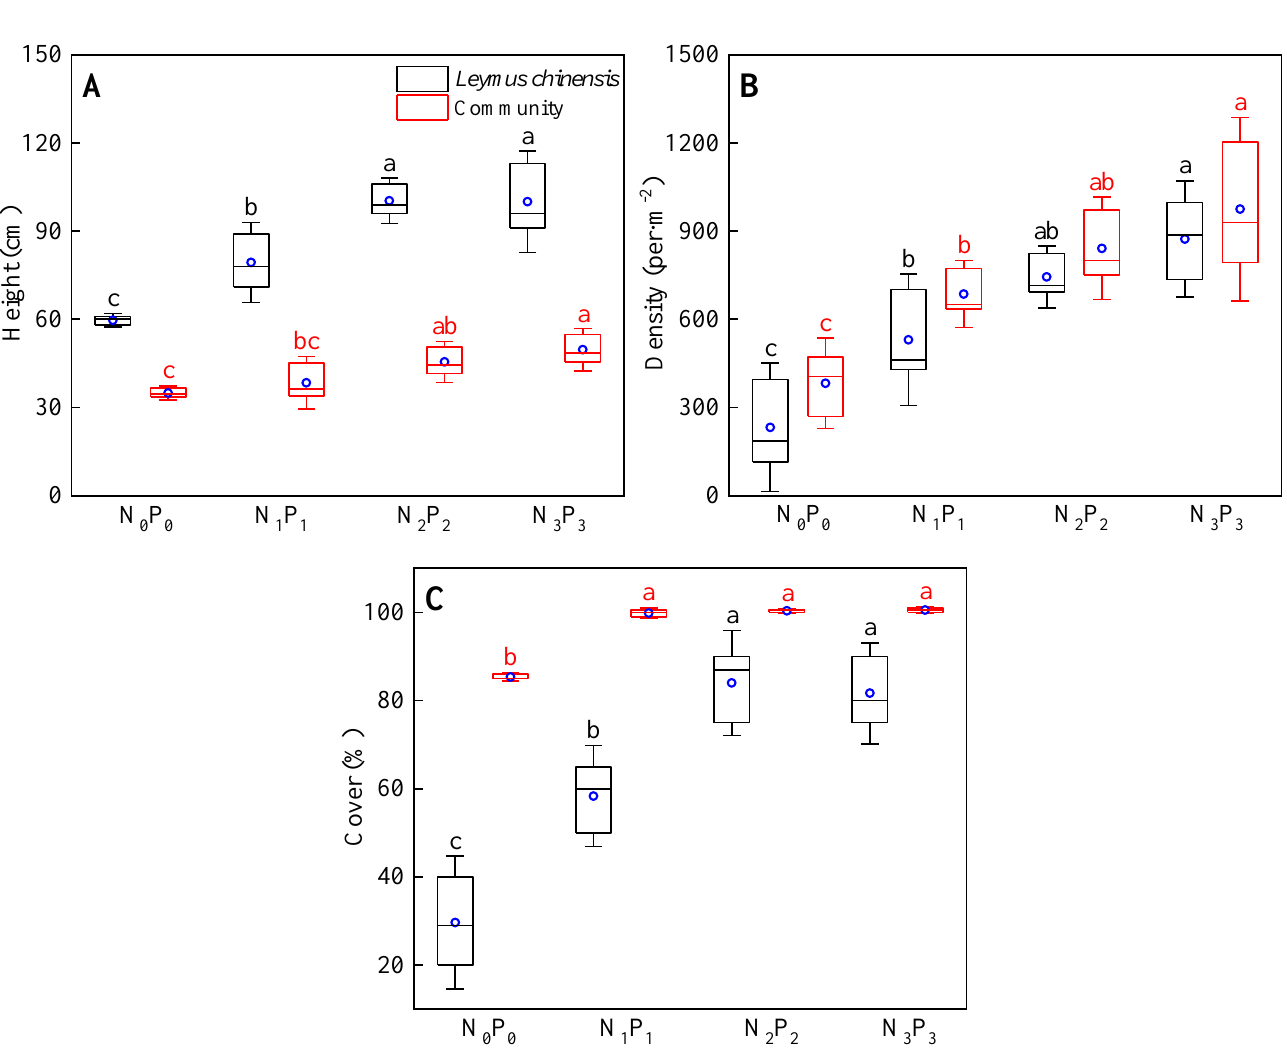
Figure 5. Quantitative characteristics of the plant community and L. chinensis among N and P addition treatments. ( A ) Height, ( B ) density, ( C ) cover. The black box line diagrams represent L. chinensis , the red box line diagrams represent the plant community (the plant community includes L. chinensis ), and the blue circles represent the average of the data indicators under the corresponding treatment. Lower case letters in the graphs indicate significant differences ( p < 0.05, LSD test).